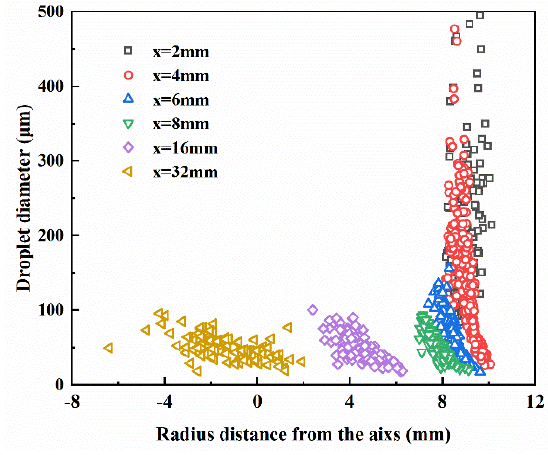
Figure 12. Radial distributions and diameters of droplets at different axial distances from the melt tube end.